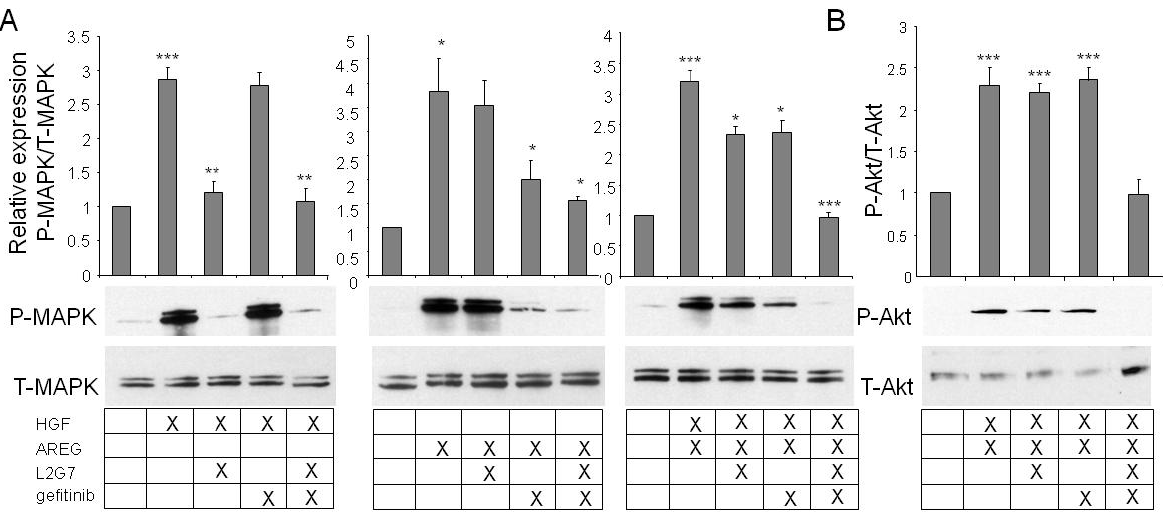
Figure 1. 201T lung cancer cells were serum deprived for 48 h followed by treatment with 10 ng/mL HGF, 10 ng/mL AREG for 10 min or pretreatment with 300 ng/mL L2G7, 20  M gefitinib or a combination of the two inhibitors for 2 h. Immunoblots were performed for ( A ) P-MAPK and T-MAPK and ( B ) P-Akt, and T-Akt. Representative immunoblots are shown for each treatment set. Immunoreactive bands from 3 independent experiments were quantitated and expressed as the ratio of P-MAPK or P-Akt to T-MAPK or T-Akt relative to control for each blot. *p < 0.05, **p < 0.005, ***p < 0.0005. Comparisons were controls vs. ligand and ligand treatment vs. inhibitors using Student’s